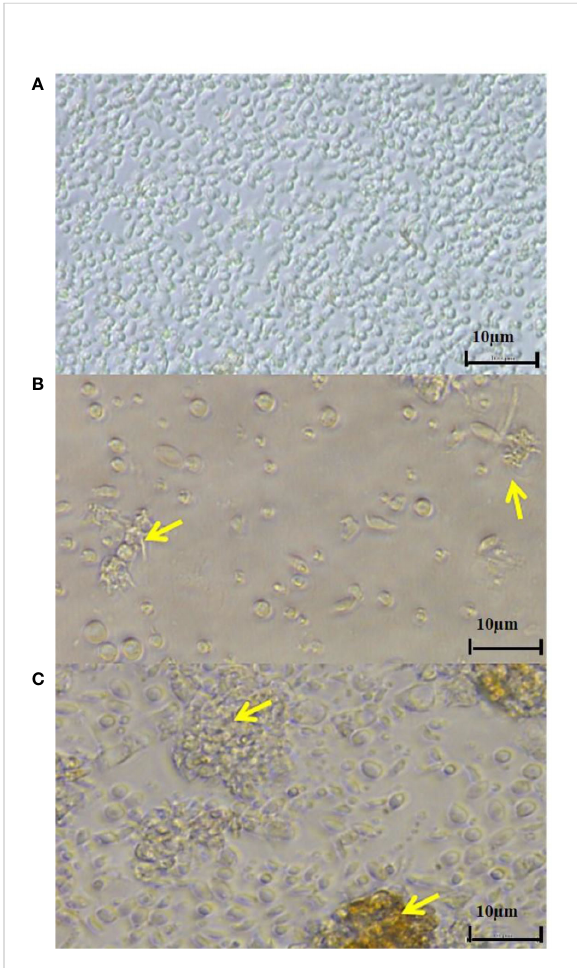
FIGURE 3 Microscopic pictures of Senegalese sole head-kidney leukocytes after exposure to (A) L15 medium or (B, C) extracellular products of T. maritimum at 100 µg mL -1 for 24 h. Yellow arrows indicate (B) inner vacuolization, cell elongation and/or degradation and (C) cell clustering and conglomeration. These results were obtained from Abdelaziz